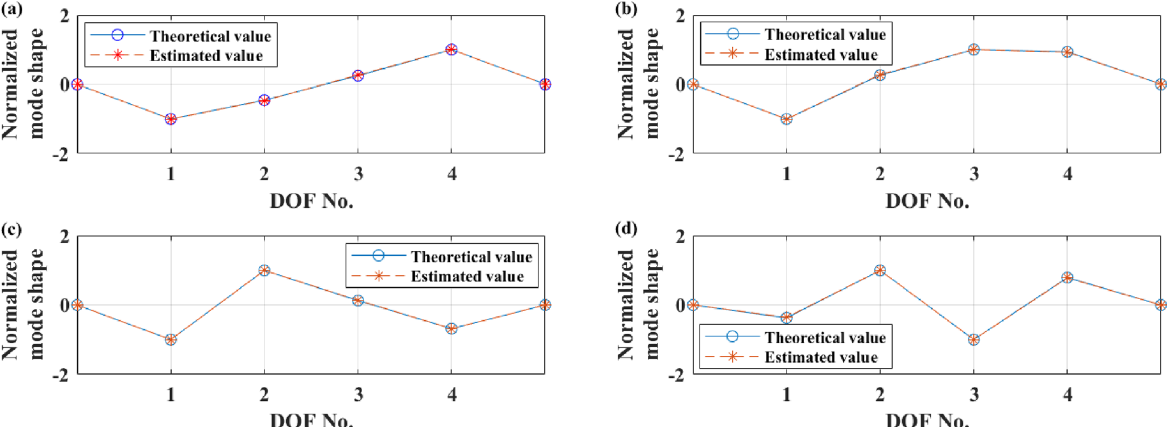
Fig. 6 Identified and theoretical mode shapes: ( a ) The 1st mode; ( b ) The 2nd mode; ( c ) The 3rd mode; ( d ) The 4th mode